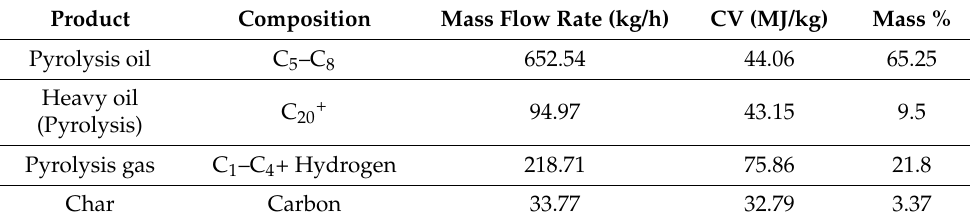
Table 5. Pyrolysis process product composition based on process simulation.